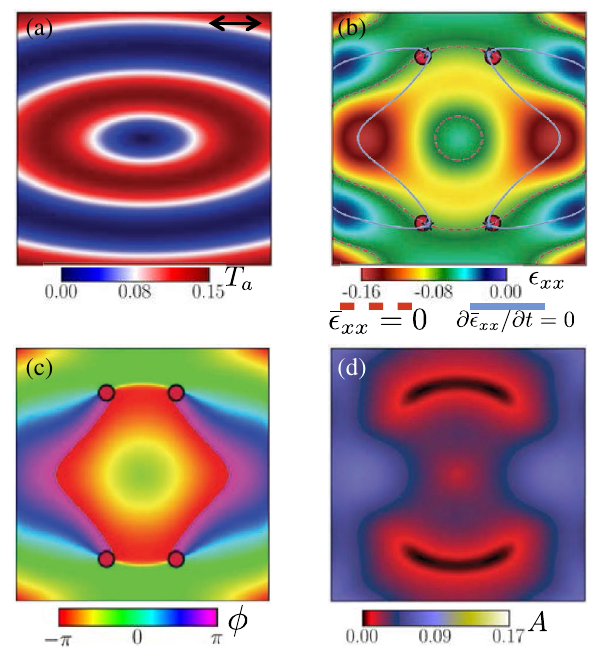
FIG. 5. Focal wave in anisotropic medium with fibers aligned along the x axis. (a) Active contraction field T elliptical ring-shaped focal pattern. (b) Strain ϵ vertical than the horizontal arms due to fiber anisotropy. Red circles and blue stars indicate the location of phase singularities calculated by the Hilbert and contour-intersection method as in Fig. 4, respectively. (c) The phase map shows mechanical singularities emerge in the absence of electrical singularities. (d) The signal amplitude A vanishes close to and around these singular points (black